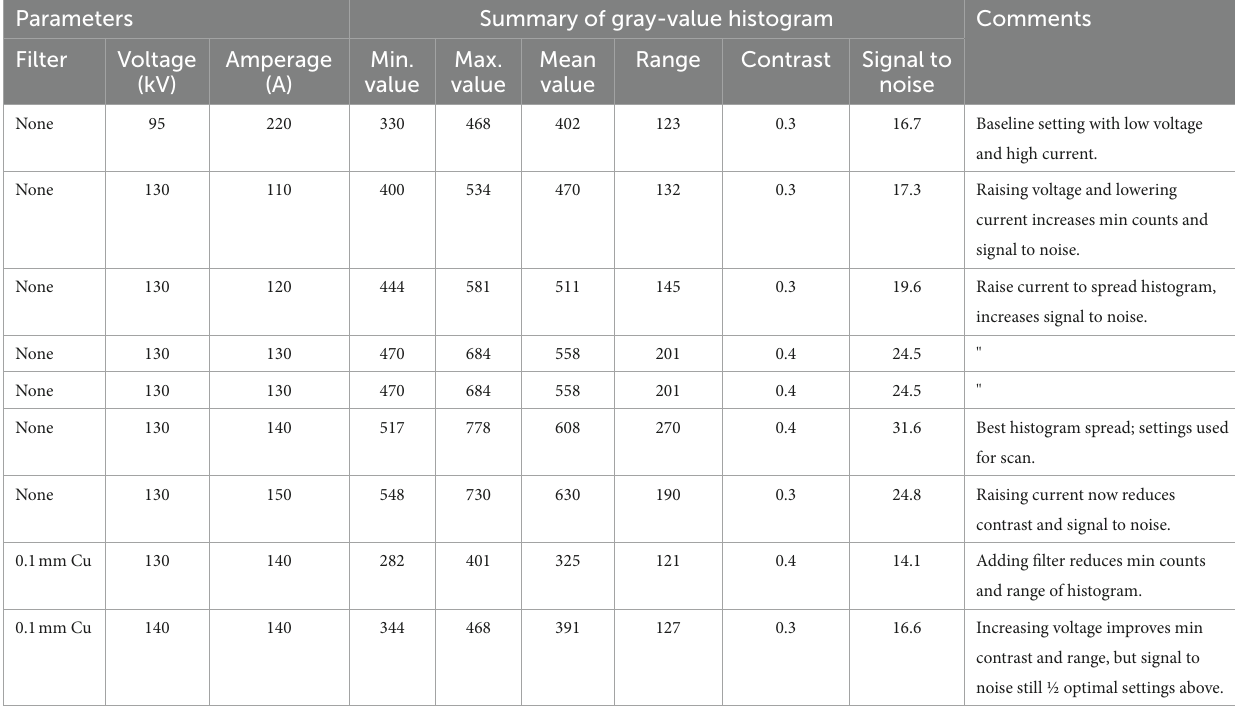
TABLE 2 Effects of X-ray parameter settings on gray-value histogram for scanning specimen USNM PAL 20943, “ Lucina ” parvilineata . Parameters Summary of gray-value